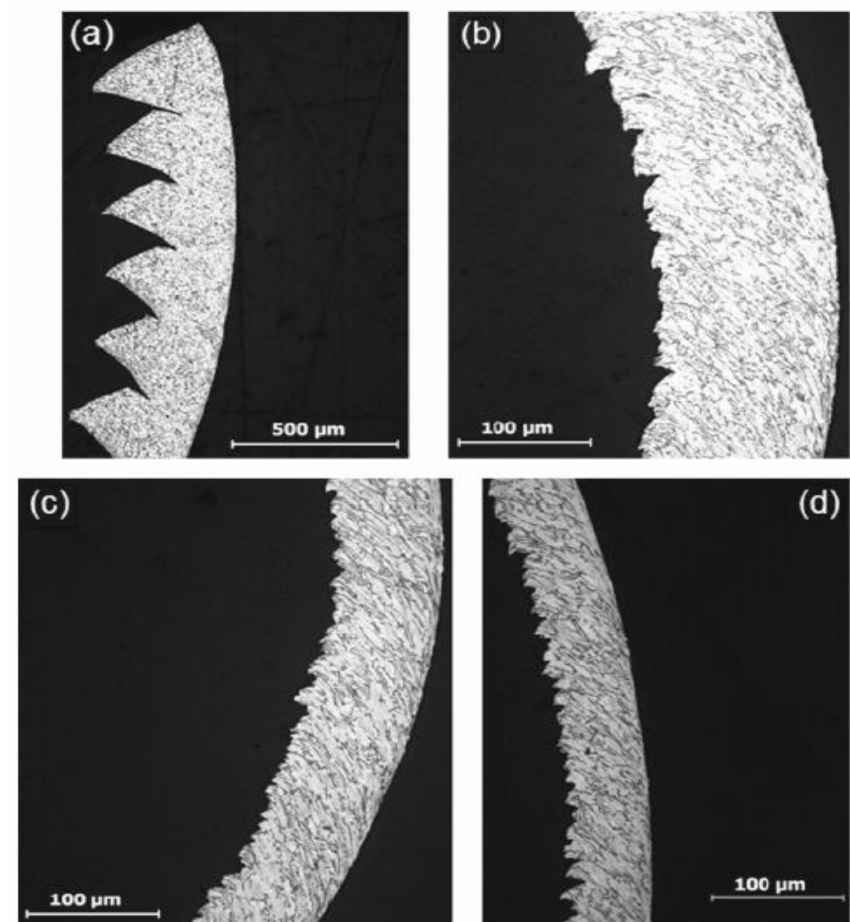
Figure 4. Experimental chips ( a ) 280 µ m, ( b ) 100 µ m, ( c ) 60 µ m and ( d ) 40 µ m [32].